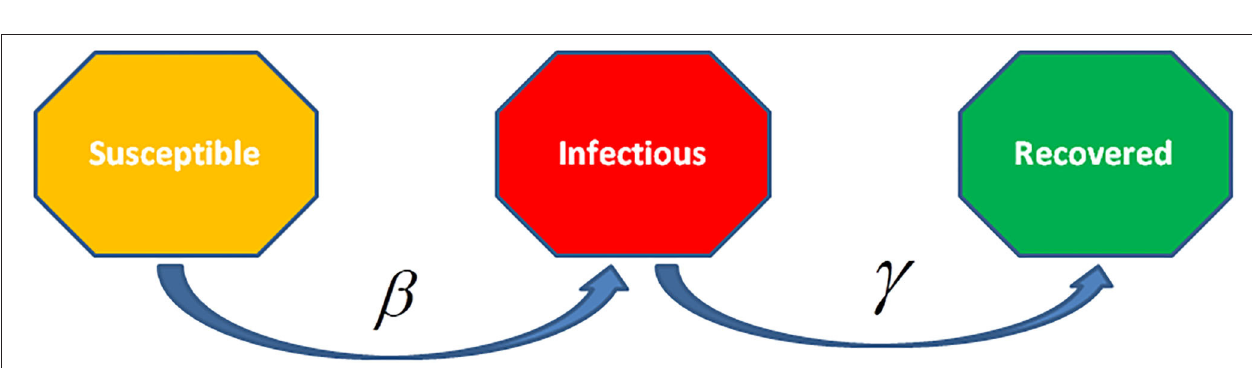
FIGURE 7 | In Susceptible-Infectious-Susceptible (SIS) Model, the infected cases are again susceptible after recovery. This model is applied to the diseases, which have the common occurrence of re-infection and relapse cases, e.g., common cold (rhinoviruses) or sexually transmitted diseases (STDs) such as Gonorrhea or Syphilis.